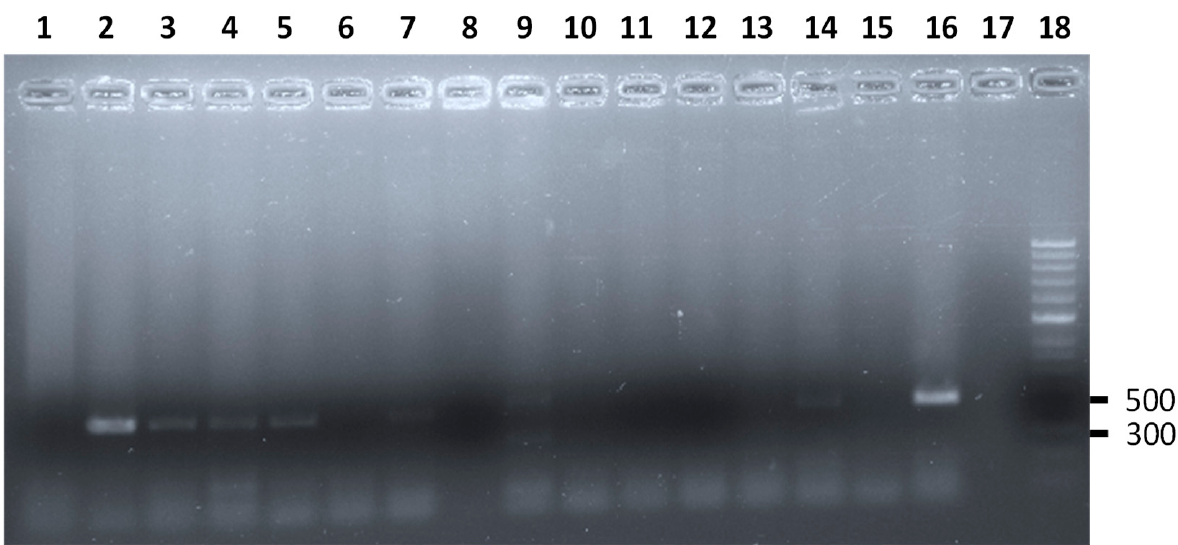
Figure 1. Results of the m-PCR assay for the simultaneous detection of stx 1 and stx 2 genes of E. coli STEC from Anolis sp. analyzed. Lane 2, 3, 4, 5, 7, and 14 amplification fragments of the stx 2 gene characteristic of E. coli STEC obtained from Anolis sp. analyzed in this study (516 bp). Lane 9 amplification fragments of the stx 1 (302 bp) and stx 2 gene characteristic of E. coli STEC obtained